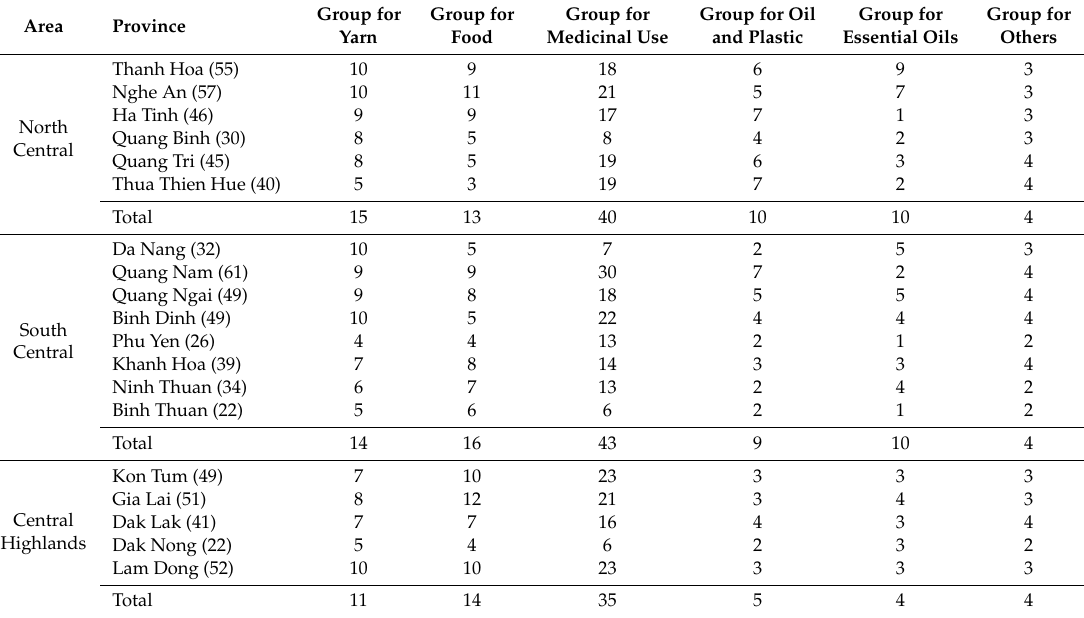
Table A2. Summary of NTFPs being cultivated, exploited, used, and traded in groups in the North Central, South Central, and Central Highland provinces (Unit: Species). Area